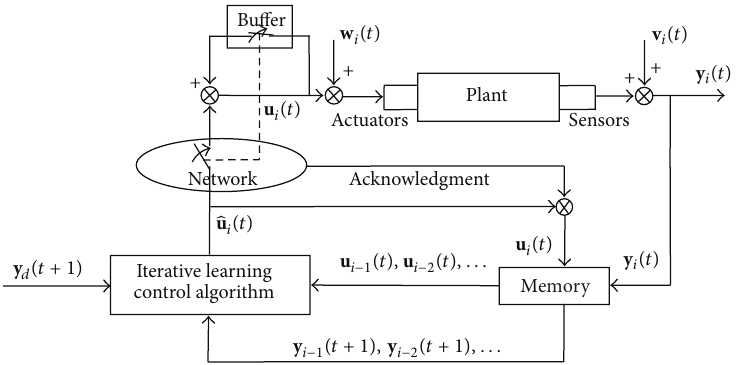
Figure 1: The schematic diagram of the networked control